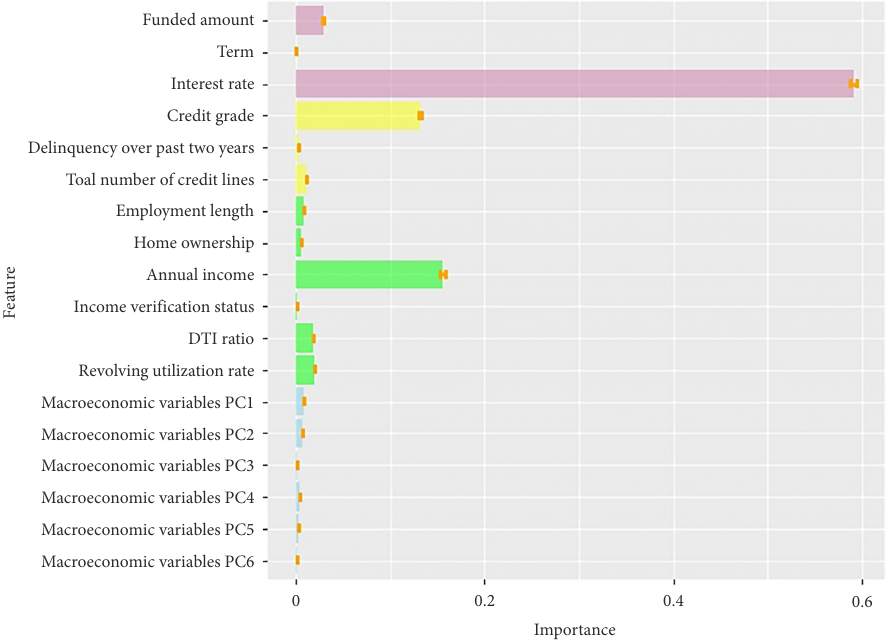
Figure 7. Feature importance of SurvXGBoost